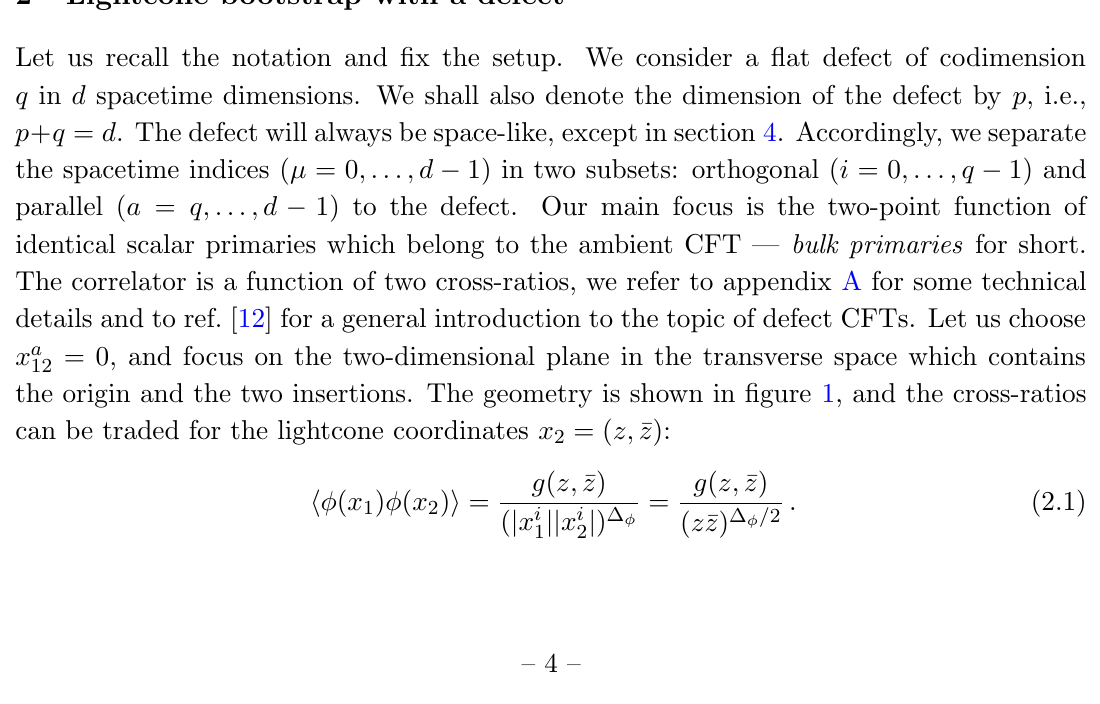
Figure 1 . The con(cid:12)guration of the insertions in transverse to the defect, where the two operators lie. The defect is space-like, it intersects the plane at the origin, and the two operators are placed at (1 ; 1) and ( z; (cid:22) z )